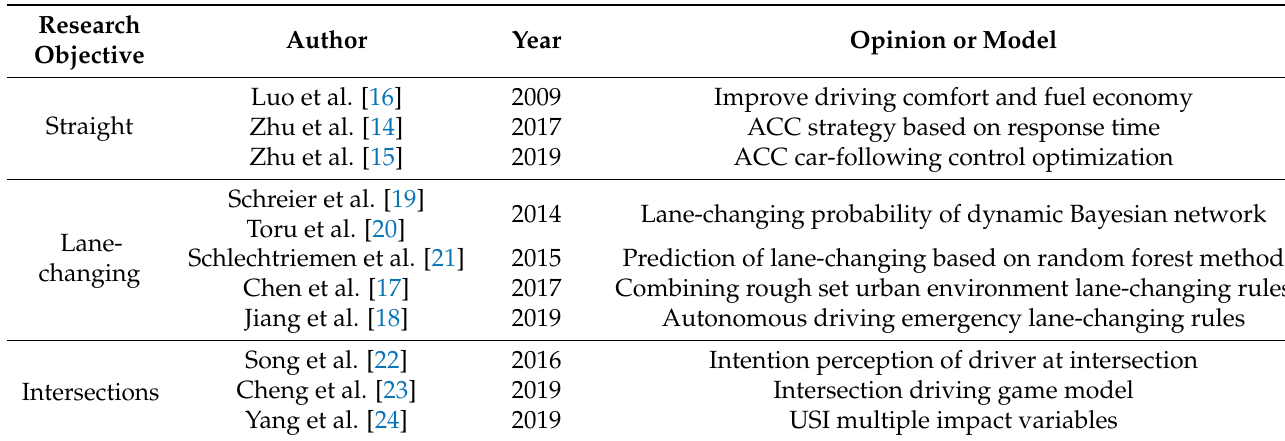
Figure 2. Structure chart of driving behavior prediction of individual intelligent vehicles. Table 2. Research summary of driving behavior prediction of individual intelligent